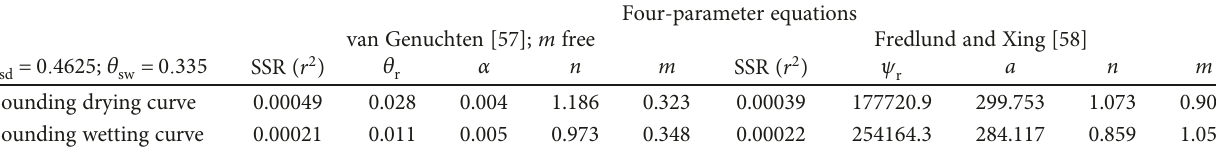
Table 3: Best- fi t parameters and SSR values for the four-parameter equations: the van Genuchten [57] and Fredlund and Xing [58] equations.